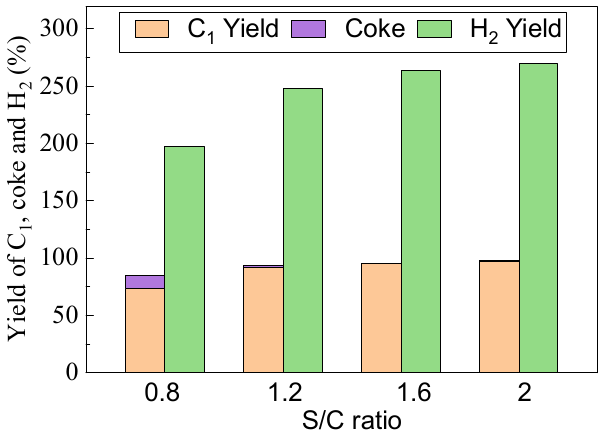
◦ C using LaFe 1 , Coke and H 2 at 900 0.6 Ni 0.4 .